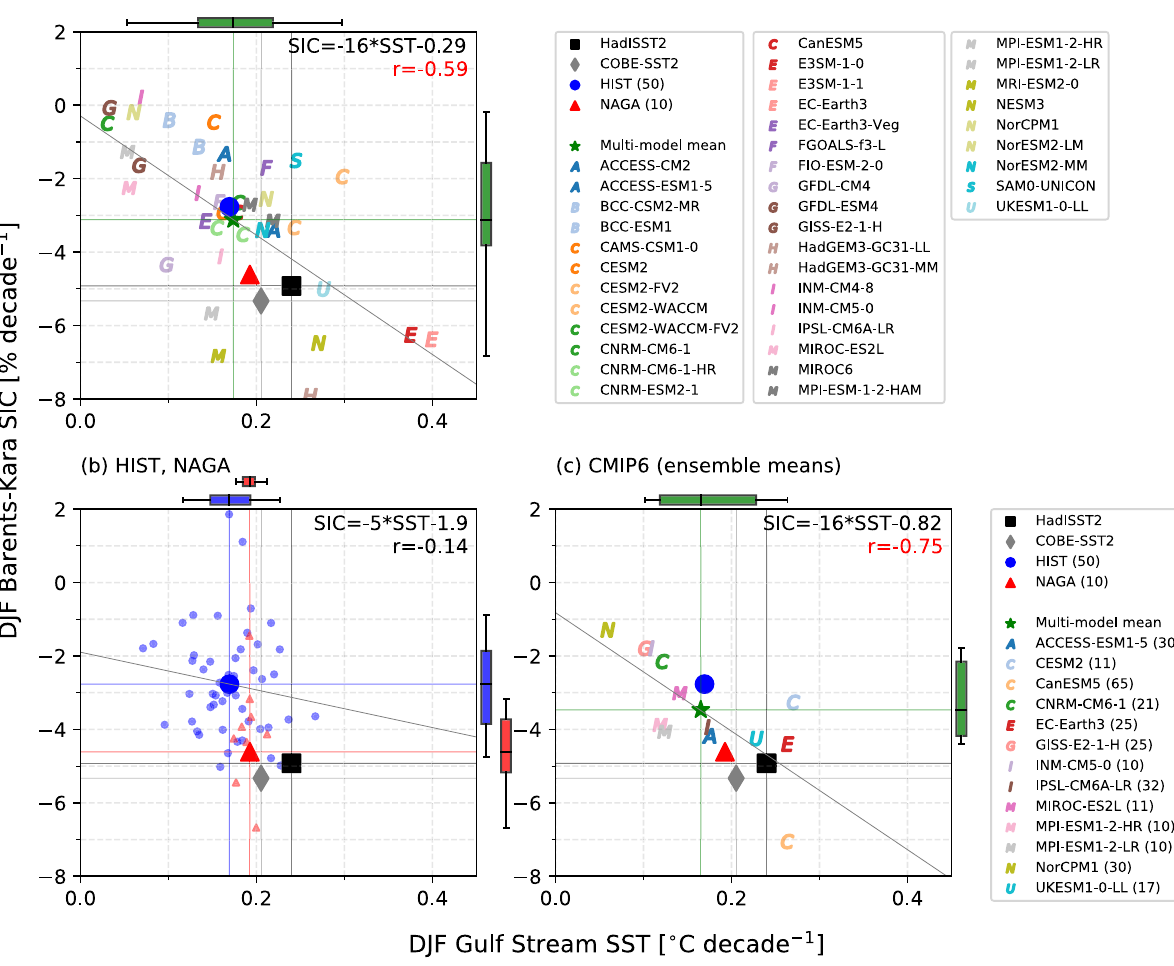
Fig. 6 Relationships between the linear trends (1970 – 2014) in SIC and SST for HIST, NAGA, CMIP6, and observations. a Scatter plots between the linear trends of DJF Gulf Stream SST [°C decade − 1 ] (horizontal axis) and Barents-Kara SIC [% decade − 1 ] (vertical axis) for one member of each CMIP6 model. Each model is denoted with different colored symbols, and the multimodel mean is indicated by a green star. The observations and ensemble means of HIST and NAGA are shown by black (HadISST2), gray (COBE-SST2), large blue (HIST ensemble mean), and large red (NAGA ensemble mean) markers. The least-squares linear fi t for CMIP6 members is shown. The correlation coef fi cient and linear regression are shown in the panel. Vertical and horizontal lines indicate the SST and SIC trends for HadISST2 (black) and COBE-SST2 (gray), and multimodel means of CMIP6 (green). Box-and-whisker plots for SIC (right) and SST (top) trends are shown. The box extends from the 25% to 75% values of the data, with a line at the ensemble mean. The whiskers show the range from 5% to 95% of the data. b As in a , but for HIST and NAGA. Small blue markers indicate 50 ensemble members in HIST, and small red markers denote 10 members in NAGA. The least-squares linear fi t for HIST members is shown. Vertical and horizontal lines indicate the SST and SIC trends for ensemble means of HIST (blue) and NAGA (red). c As in a , but for the ensemble means of CMIP6 models having more than ten ensemble members. Each model is denoted with different colored symbols, and the multimodel mean is indicated by a green Statistical analysis . The linear trends of DJF SIC and SST in the Barents-Kara Sea and Gulf Stream regions are calculated by least-squares linear regression. The Barents-Kara SIC time series are de fi ned as the area-averaged DJF mean SIC from 20° – 70° E and, 65° – 85° N. Gulf Stream SST time series are de fi ned as the area- average of the DJF mean SST from 30° – 80° W and, 30° – 50° N. We also calculate the DJF SST averaged over the North Atlantic (0 ° – 65 ° N, 0 ° – 80 ° W) for the AMV index. To investigate the relationship between the Barents-Kara SIC trend and Gulf Stream SST trend in ensemble members, correlation coef fi cients between Barents- Kara SIC and Gulf Stream SST are calculated. Statistical tests for the correlation coef fi cients are performed based on a two-tailed Student ’ s t-test at the 95% con- fi dence level. The modi fi ed Mann ‐ Kendall trend test for autocorrelated data is adapted for signi fi cance test of linear trends at 95% con fi dence level 43,44 . The arithmetic mean of all ensemble members is de fi ned as the ensemble mean in this study. However, this de fi nition may include the effect of the difference in the number of ensembles. Therefore, when we compare the differences in statistics for time series and linear trends (e.g., the ensemble mean, standard deviation, and quartiles) between HIST and NAGA, a comparison was made between the same ten ensemble members as follows. First, ten members are randomly selected from 50 members of HIST using the Monte Carlo method. Using selected ten members,